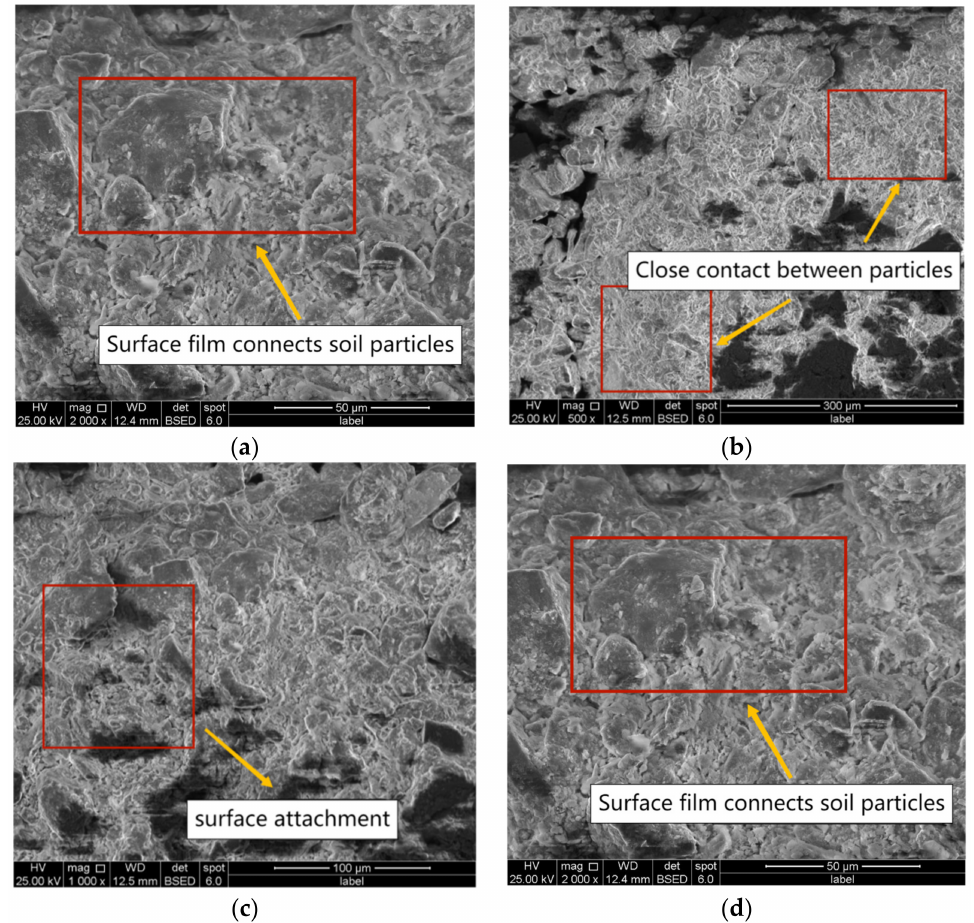
Figure 15. Microscopic image of the sample SMS-3. ( a ) 200 times; ( b ) 500 times; ( c ) 1000 times; ( d ) 2000 times.